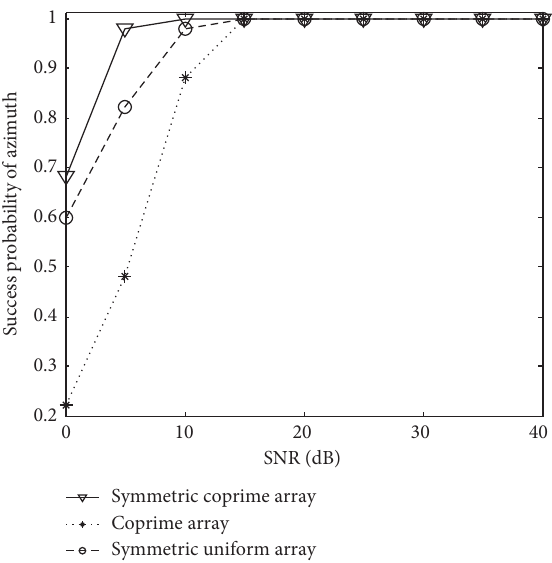
Figure 13: The probability of success of Table 1: The explanation of variables and notations.